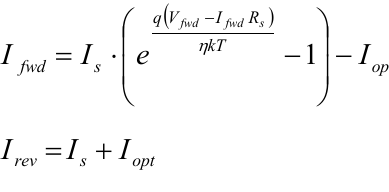
, 1 = 2.2 x 10 -12 A, η =1.04, s (L ) = 1.67 x 10 -9 opt 1